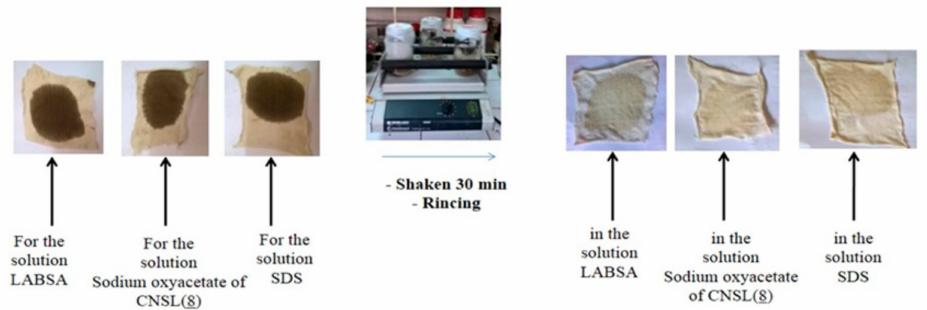
Figure 4. Detergent with LABSA, sodium oxyacetates of CNSL ( 8 ), and SDS.